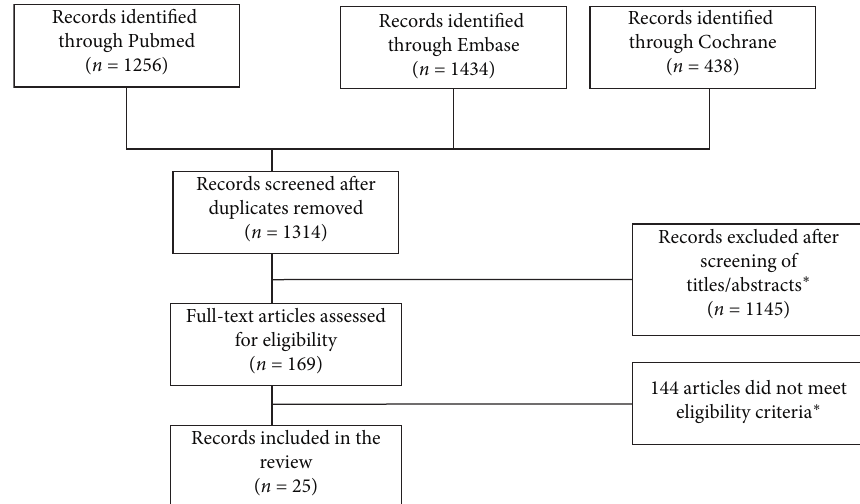
Figure 1: Study selection